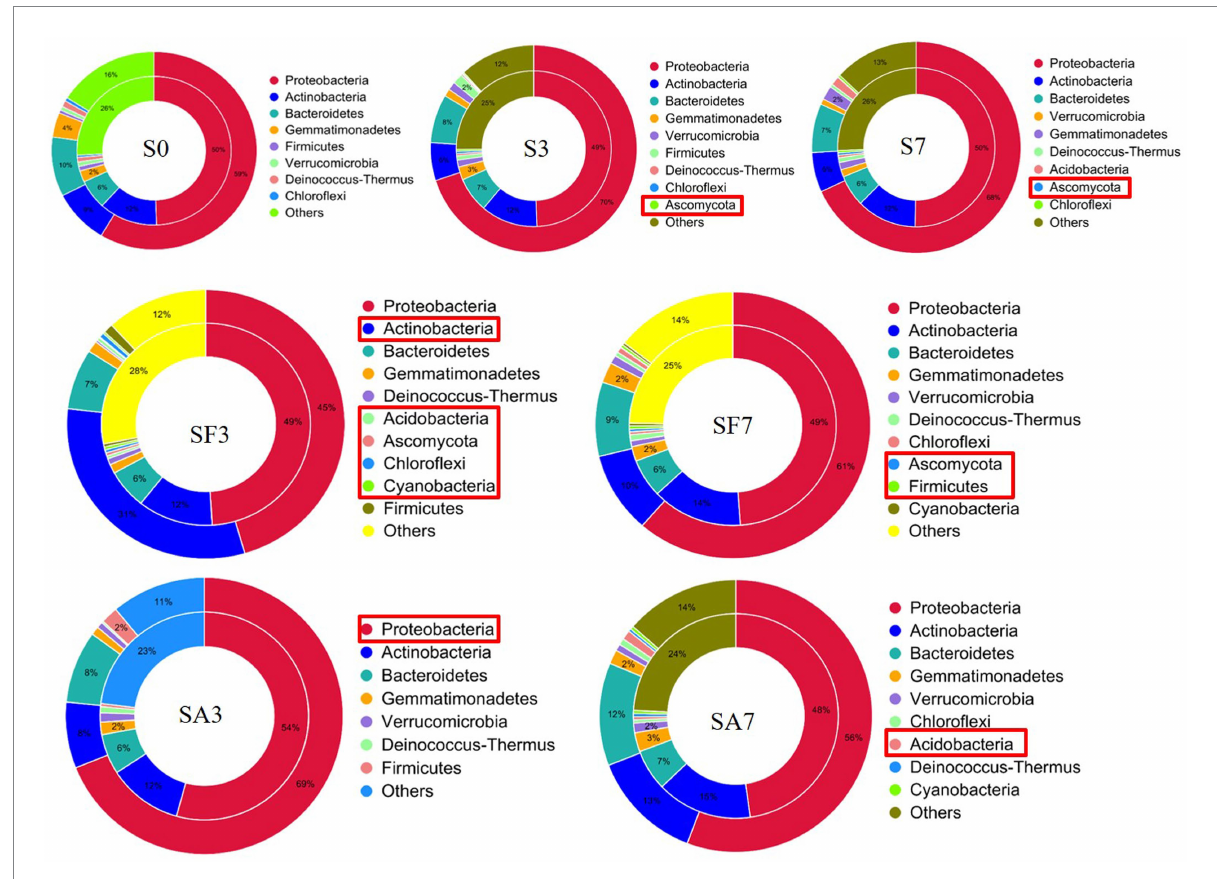
FIGURE 8 Comparison of the relationship between resistance genes and main phyla in the different soil samples S0, Mock-inoculation control, before treatment; S3, mock-inoculation control, 3 dpi; S7, mock-inoculation control, 7 dpi; SA3, SA + FON treatment, 3 dpi; SA7, SA + FON treatment, 7 dpi; SF3: FON treatment, 3 dpi; SF7, FON treatment, 7 dpi. The inner circle is the phylum distribution for the antibiotic resistance ontology (ARO) cluster, and the outer circle is the phylum distribution for all sample genes in the group. FON, Fusarium oxysporum f. sp. niveum ; SA, salicylic acid; dpi, days post